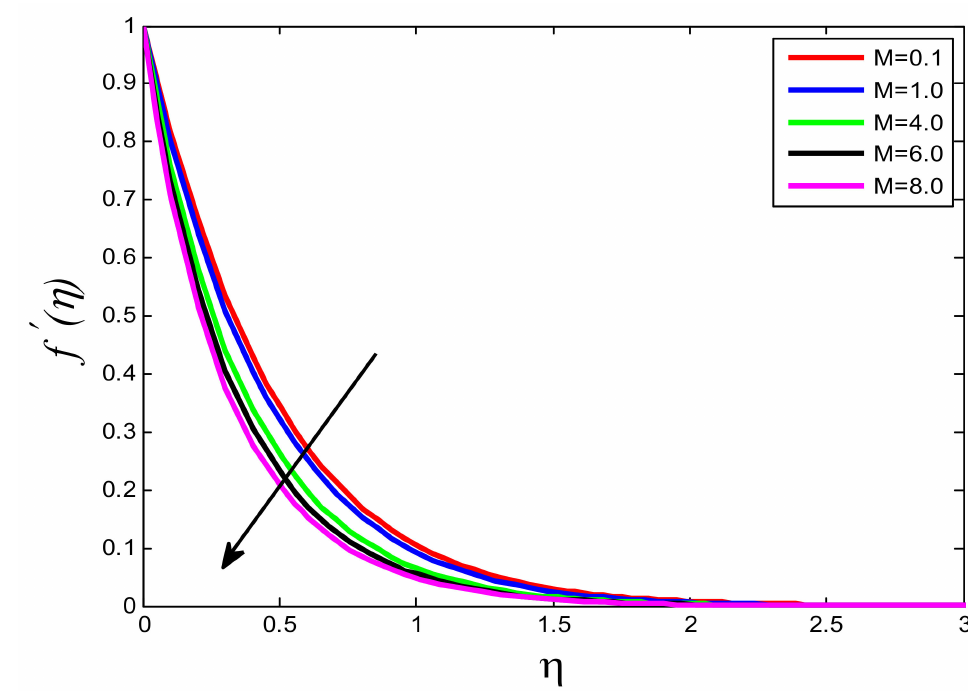
Figure 21. Influence of M on f (cid:48) ( η )